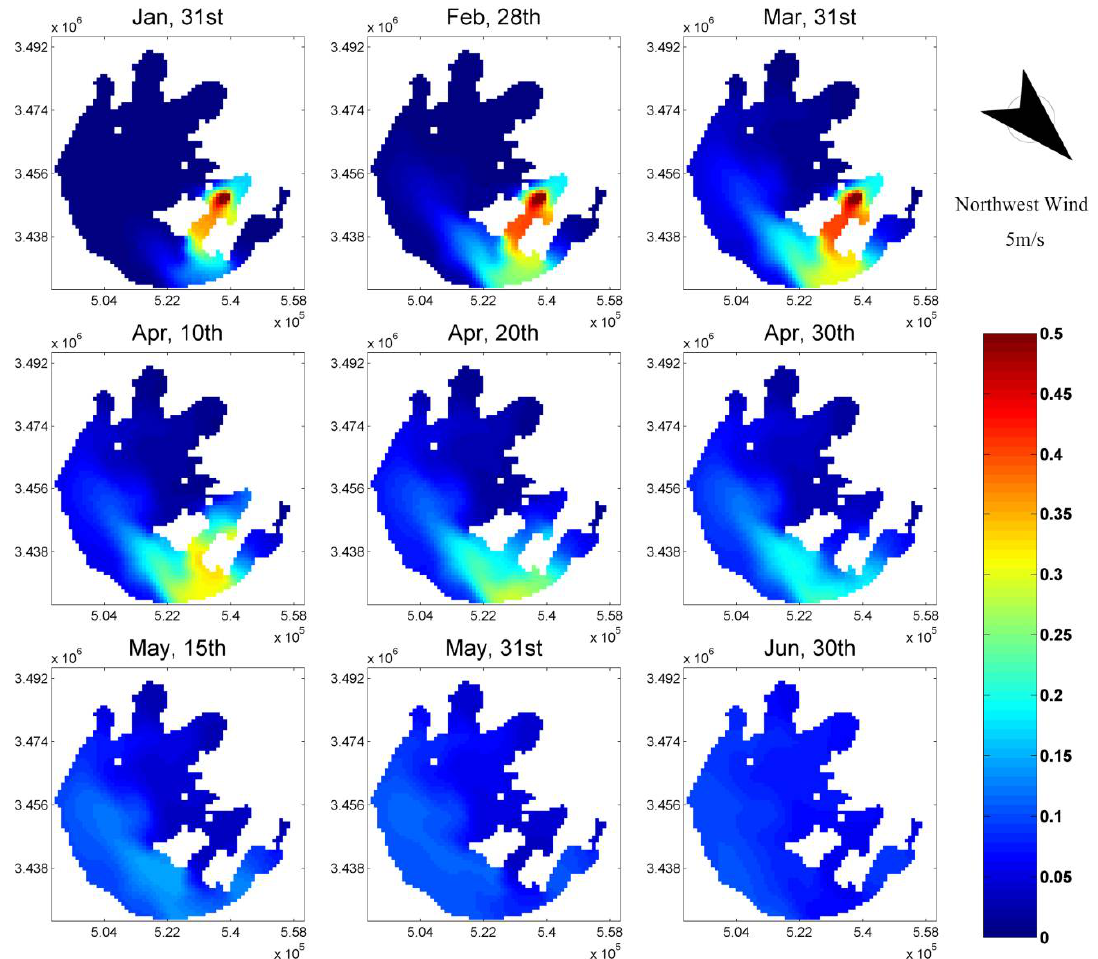
Figure 16. Time series of tracer concentration images, with the model driven by constant 5 m/s northwest wind. Unit in the figure is kg/m 3 . Water 2018 , 10 , x